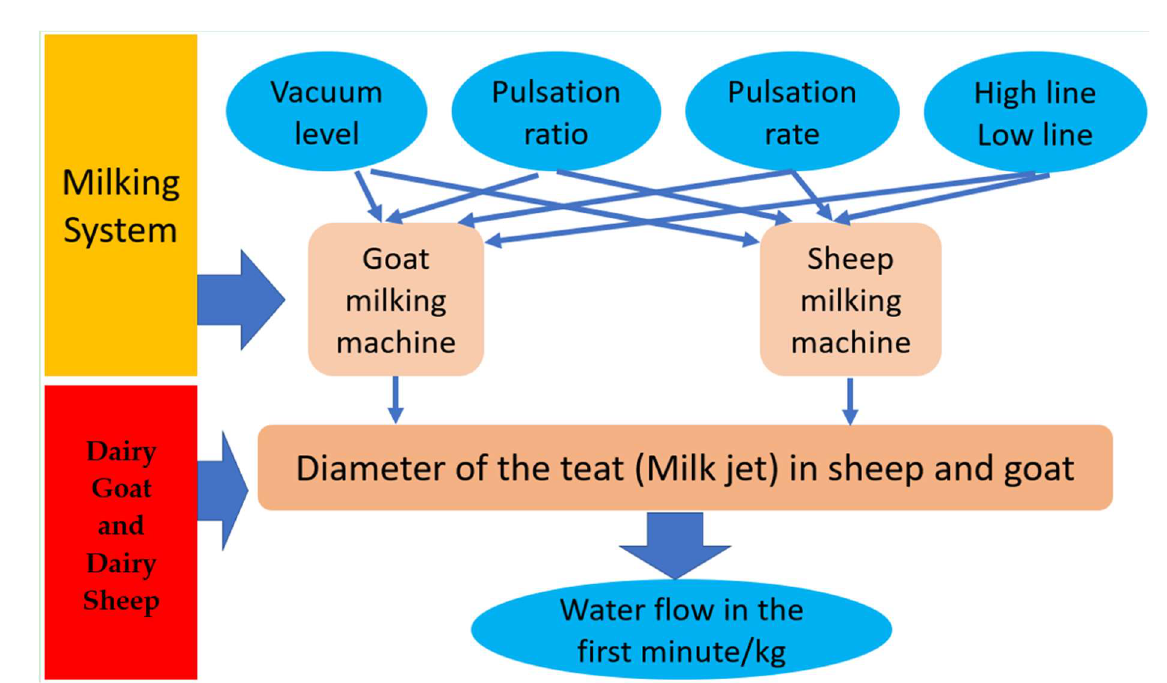
Scheme 1. Overview on methodology of the parameters of two areas: milking system and the